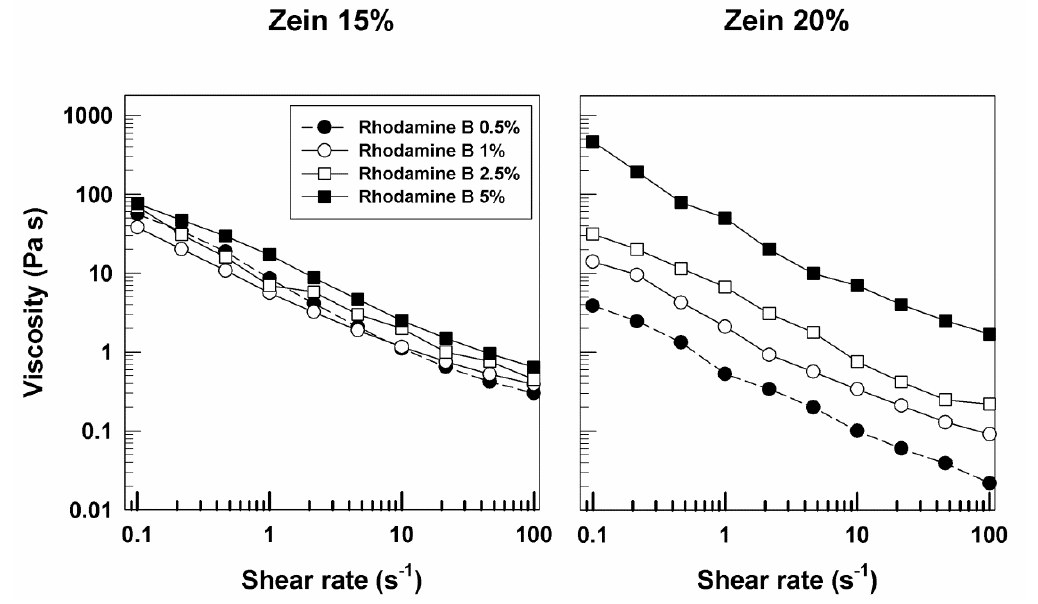
Figure 5. Evaluation of viscosity of zein samples containing rhodamine B as a function of the shear rate.